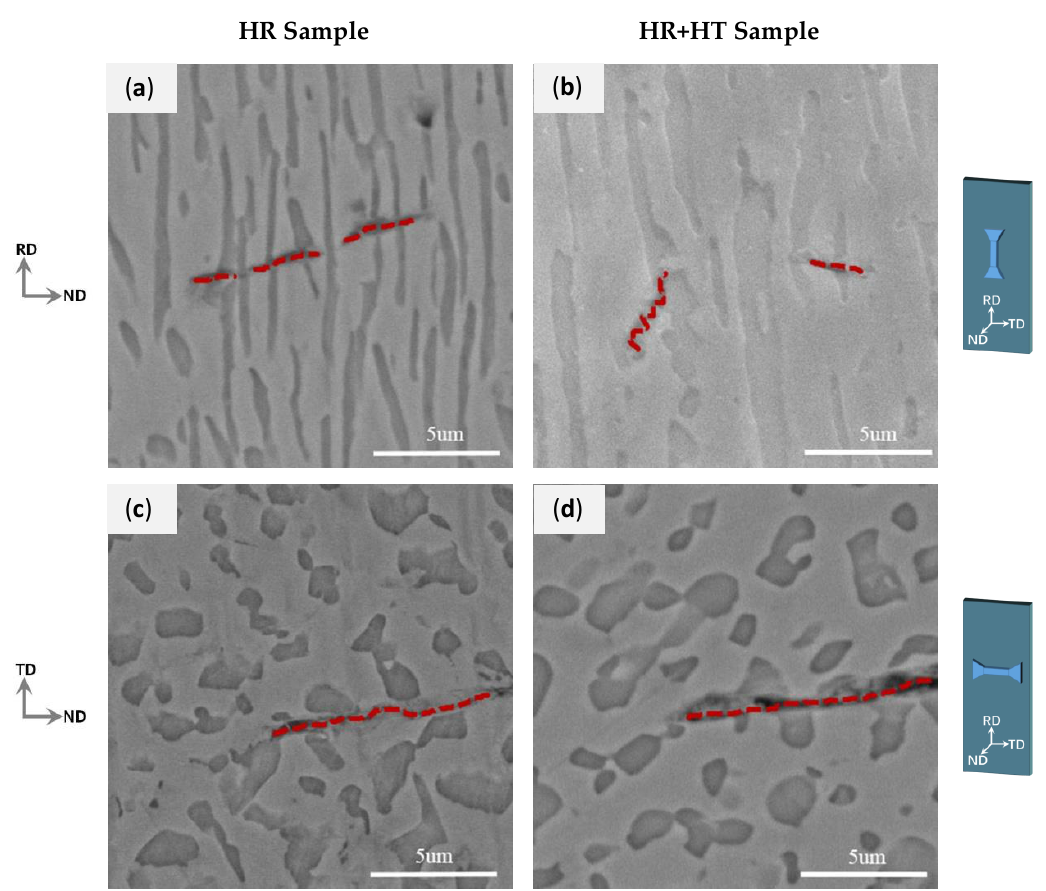
Figure 10. Microcracks in the cross-section of HR and HR+HT sample. ( a , b ): RD-ND plane; ( c , d ): TD-ND plane.